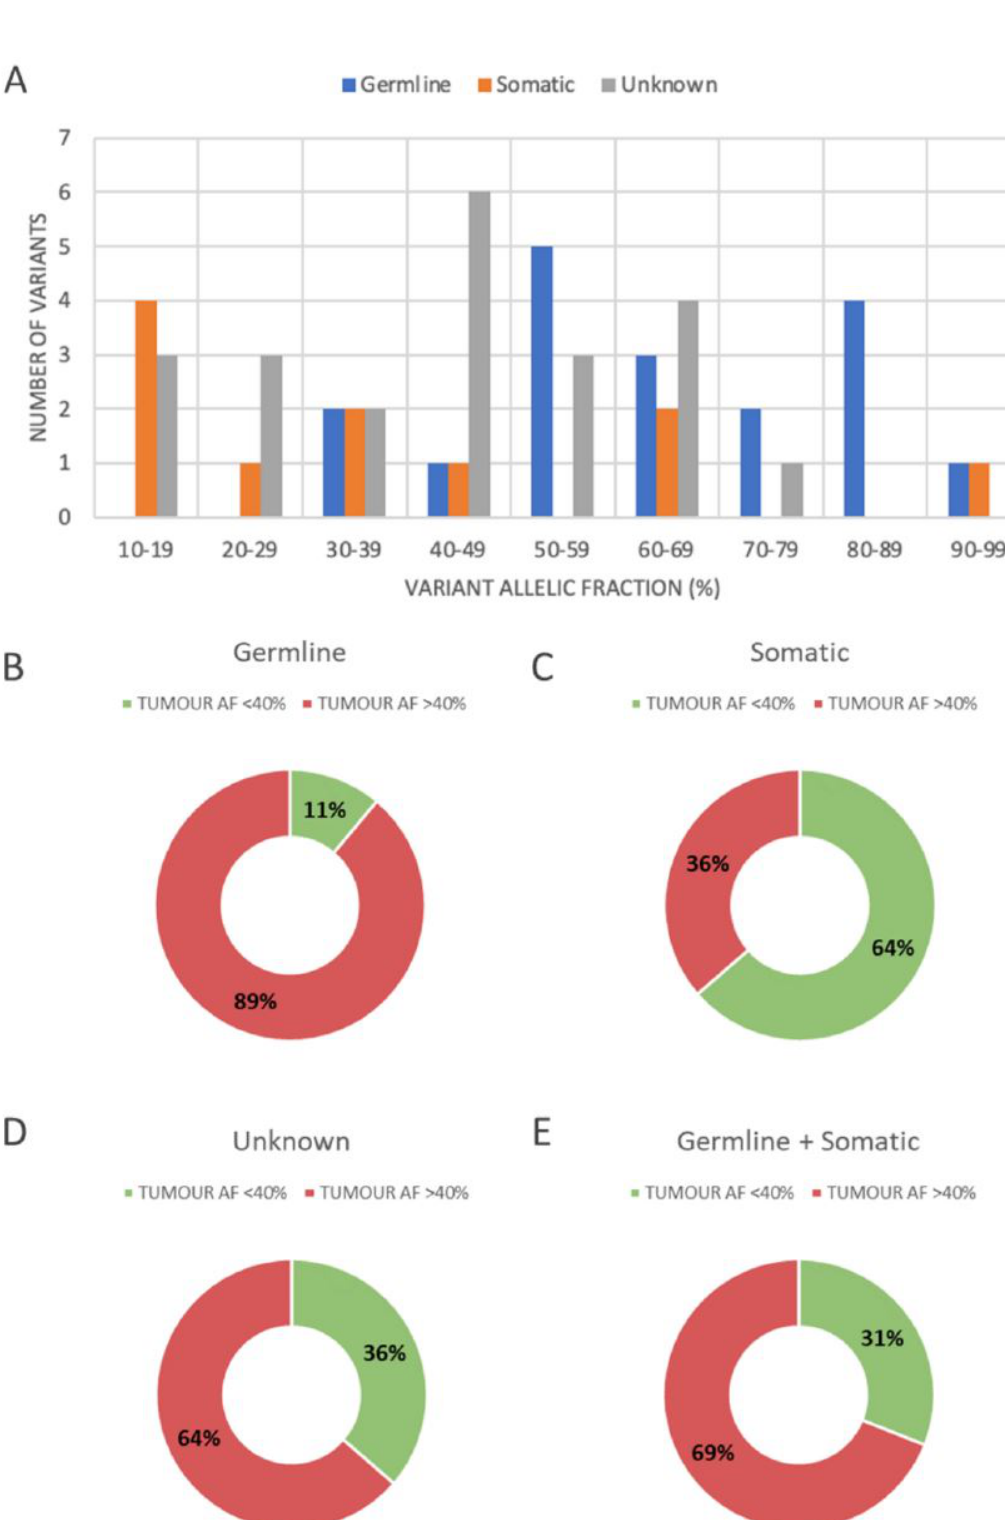
Figure 3. Distribution of sequence variant origin based on tumour variant allelic fraction (VAF). The number of variants of somatic, germline and unknown origin with tumour VAFs are shown in ( A ). The proportion of variants with a VAF greater than and less than 40% for germline origin ( B ) demonstrates that germline variants are more likely to have a high VAF, while the opposite is true for somatic variants ( C ). The distribution of variants that were present in tumour analysis, but did not have matching germline analysis ( D ) show a distribution very similar to the combined germline plus somatic origin ( E